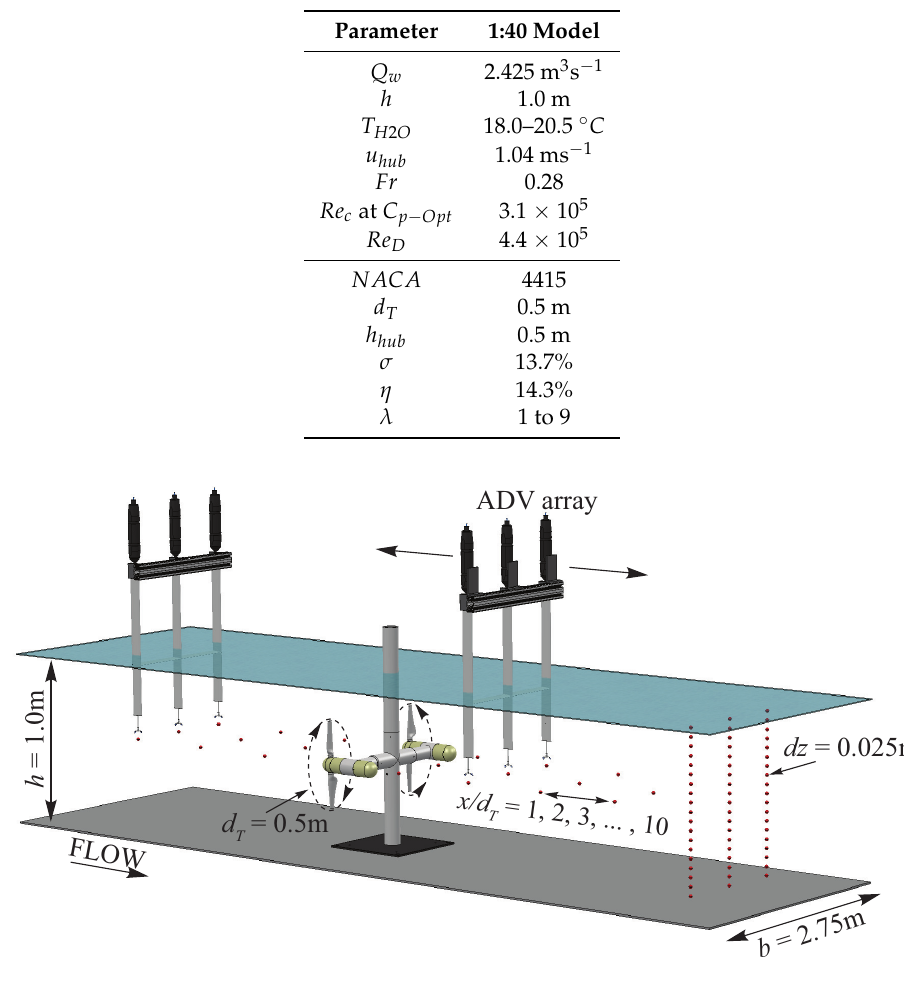
Figure 3. Experimental setup and ADV sampling location schematic of RM1 testing in the SAFL Main Channel